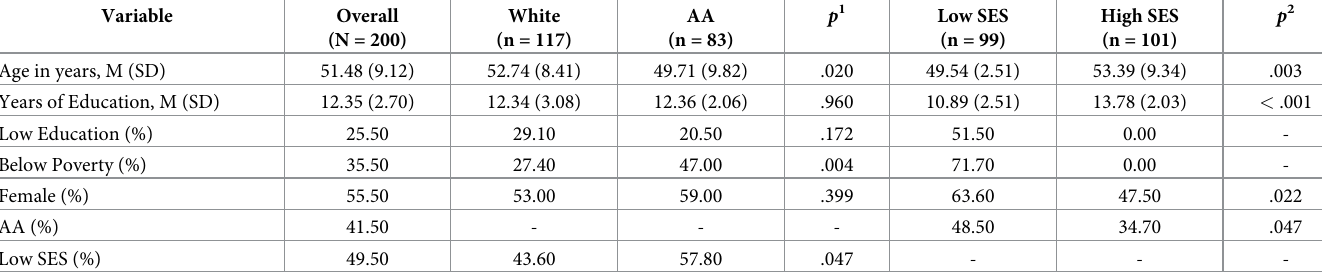
Table 1. Demographic characteristics in the overall sample and across race and